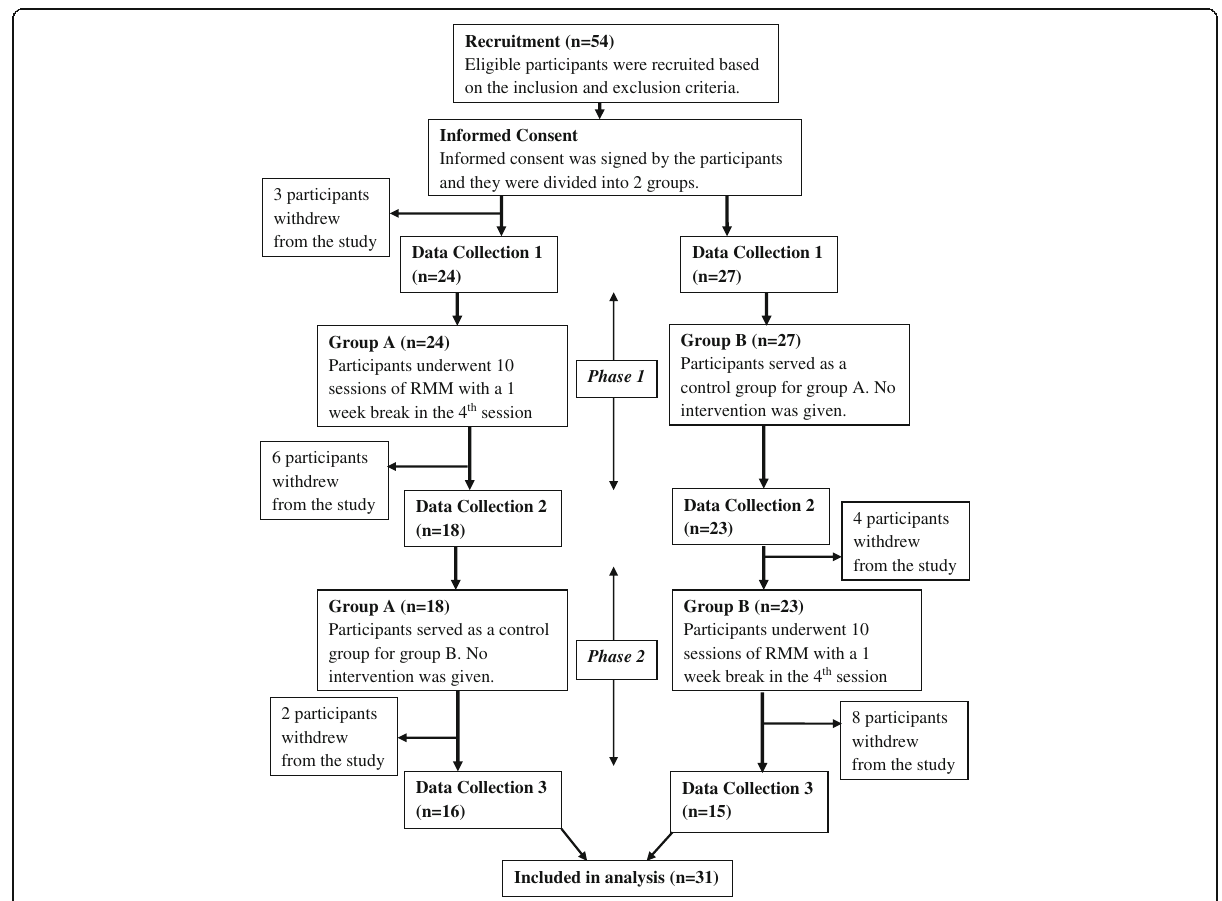
Fig. 1 Study flow chart depicting dropouts at each time point of the study, the different data collection time points as well as the cross over design